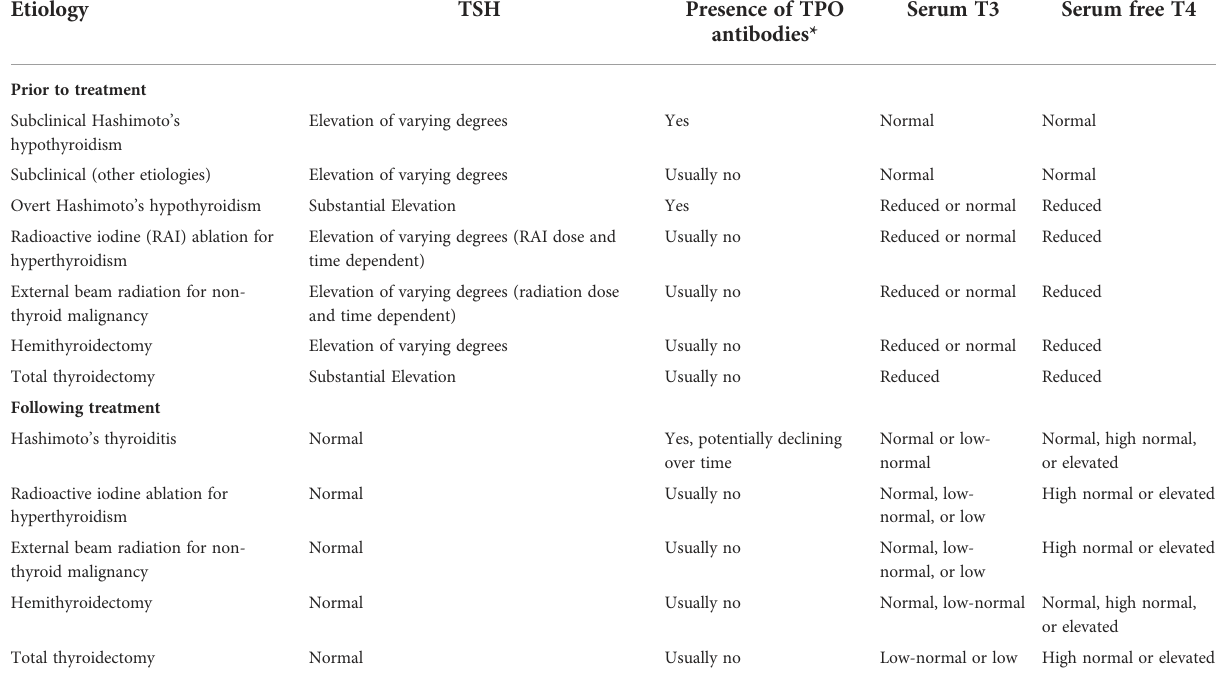
TABLE 2 Potential differences between primary hypothyroidism of various